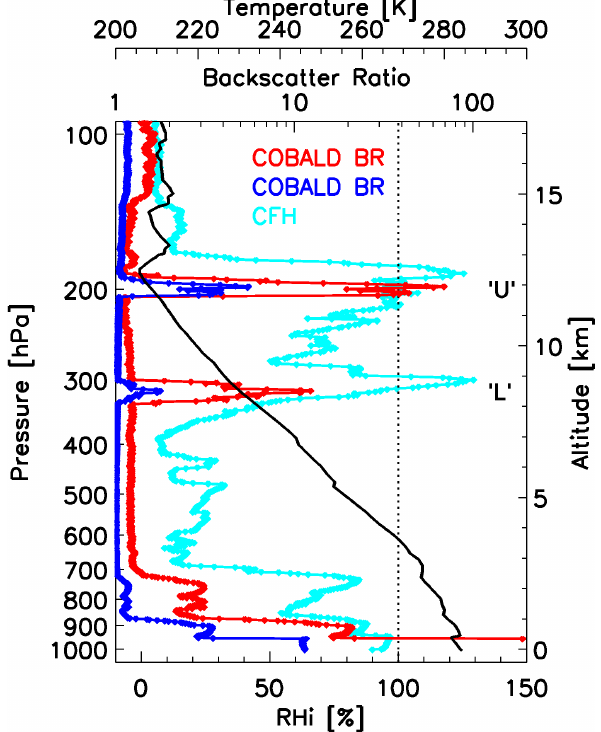
Fig. 1. Profile of balloon sounding on 6 November 2008 above Lindenberg, Germany. Blue and red lines: backscatter ratios ( BSR ) at 455nm and 870nm wavelength, respectively, measured by COBALD. Cyan line: relative humidity with respect to ice (RH ice ) obtained from the CFH frost point measurement. Quantities shown as function of barometric pressure and GPS-measured geometric al- titude. The upper and lower cirrus clouds are termed “U” and “L”,